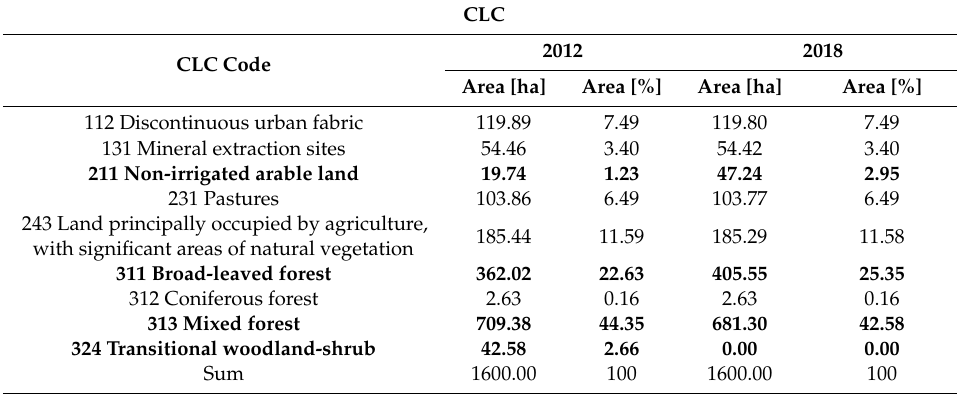
Table 5. Evaluation of NDVI index for the considered period.